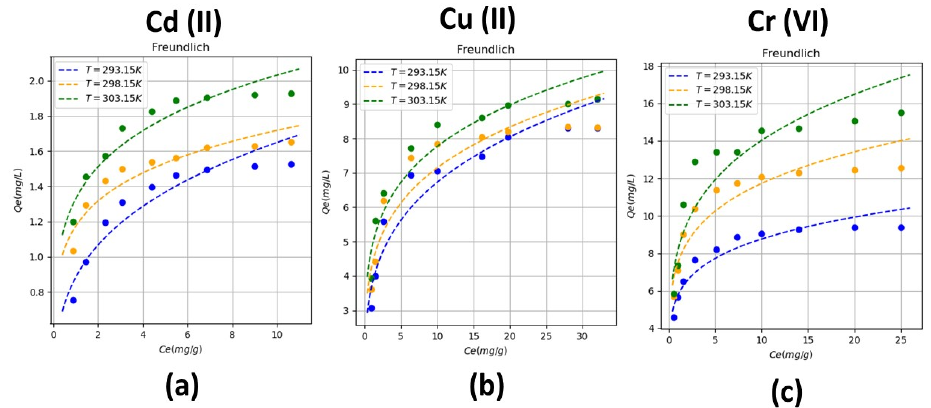
Figure 3. Isotherm of Freundlich at different temperatures (T) T = 303.15 K (green), T = 298.15 K (yellow) and T = 293.15 K (blue) for ( a ) Cd (II), ( b ) Cu (II) and ( c ) Cr (VI).